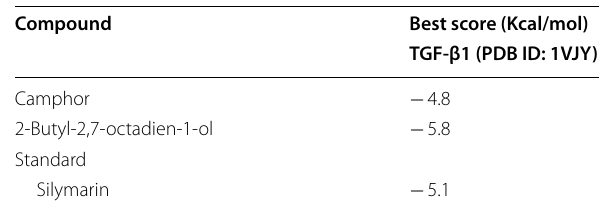
Table 7 Binding affinity of ethanolic extract of L. rugosa for